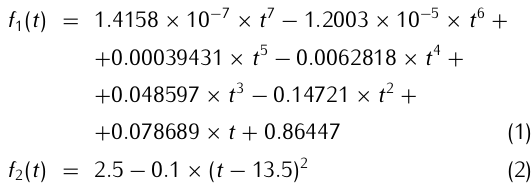
Figure 8. Residential load profile on a summer